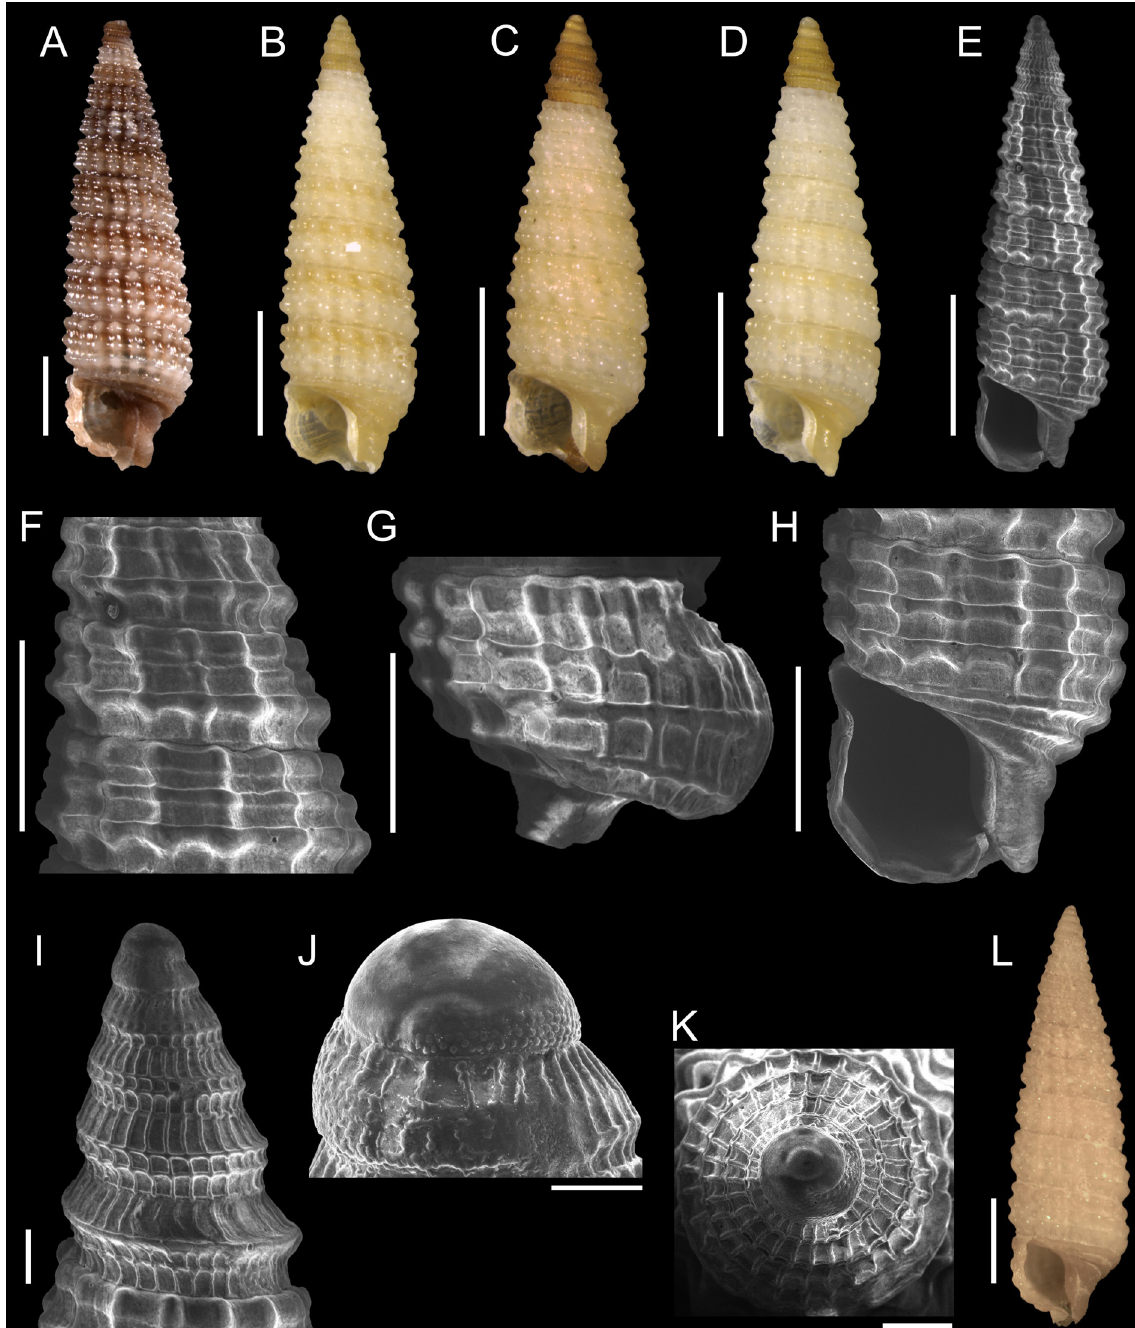
Fig. 18. A . Similiphora apexdiversus (Rolán & Lee, 2008) comb. nov., holotype, FLMNH 363887. B–L . Similiphora sp. 1. B–D . MNRJ 32566*, 3.75 mm, 3.17 mm and 3.25 mm, respectively. E–K . Same shell as C. L . MORG 16441*, 5.18 mm. Scale bars: A–E, L = 1 mm; F–H = 500 µm; I, K = 100 µm; J = 50 µm